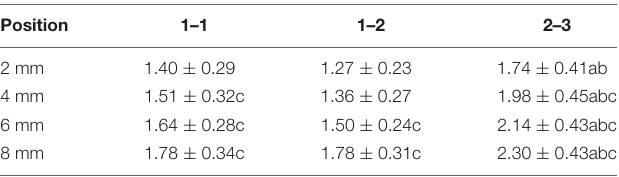
TABLE 5 | CBCT results of lingual cortical bone thickness in the mandibular anterior tooth region (mm, ¯ x ± s).